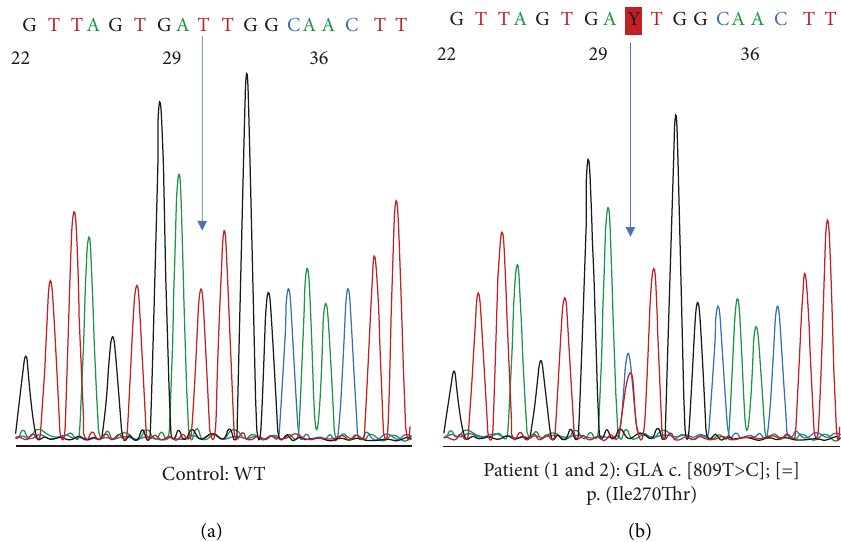
Figure 1: Sanger sequencing of exon 6 of the GLA gene. (a) Normal control showing wild-type (WT) sequence. (b) Patient sequence with GLA variant c.809T > C p.(Ile207Tr) in heterozygosity. Te arrow indicates the nucleotide position with the sequence variant.